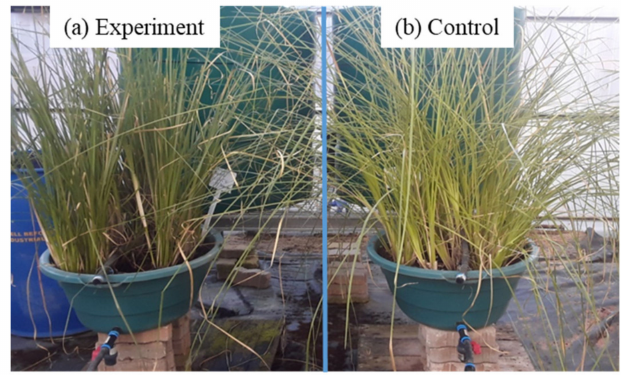
Figure 1. Experimental set-up of the SSVF-CW. ( a ) experiment and ( b )